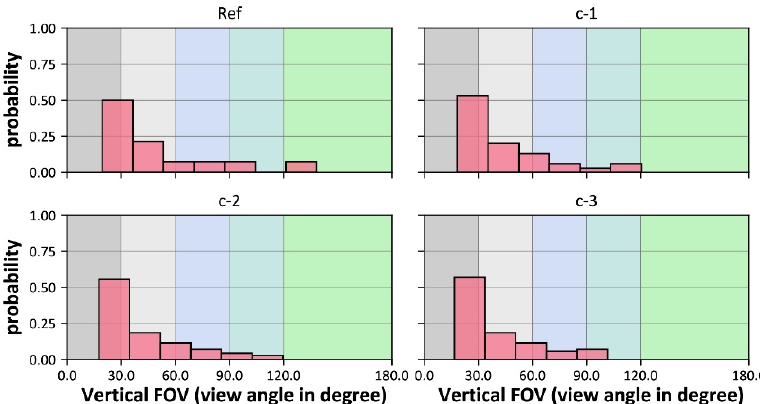
Figure A5. Impacts of external overhangs installed around window edges on the histograms of ver- tical FOVs for case studies of scenario-c.